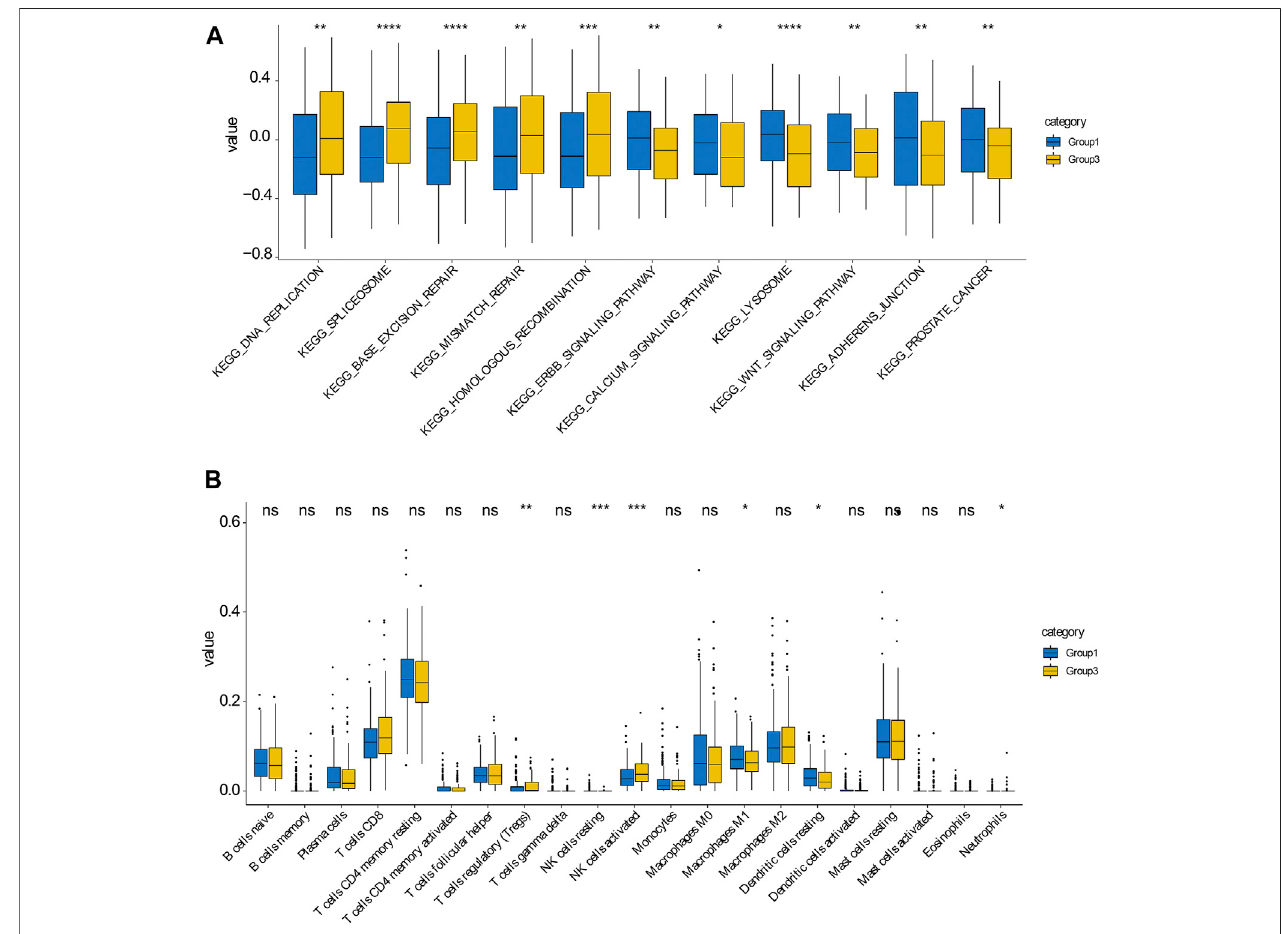
FIGURE5| KEGGenrichmentanalysisingroup1andgroup3subtypes (A) KEGGenrichmentanalysisofgenesingroup1andgroup3subtypes,respectively. (B) KEGG enrichment analysis of cells in group 1 and group 3 subtypes, respectively.